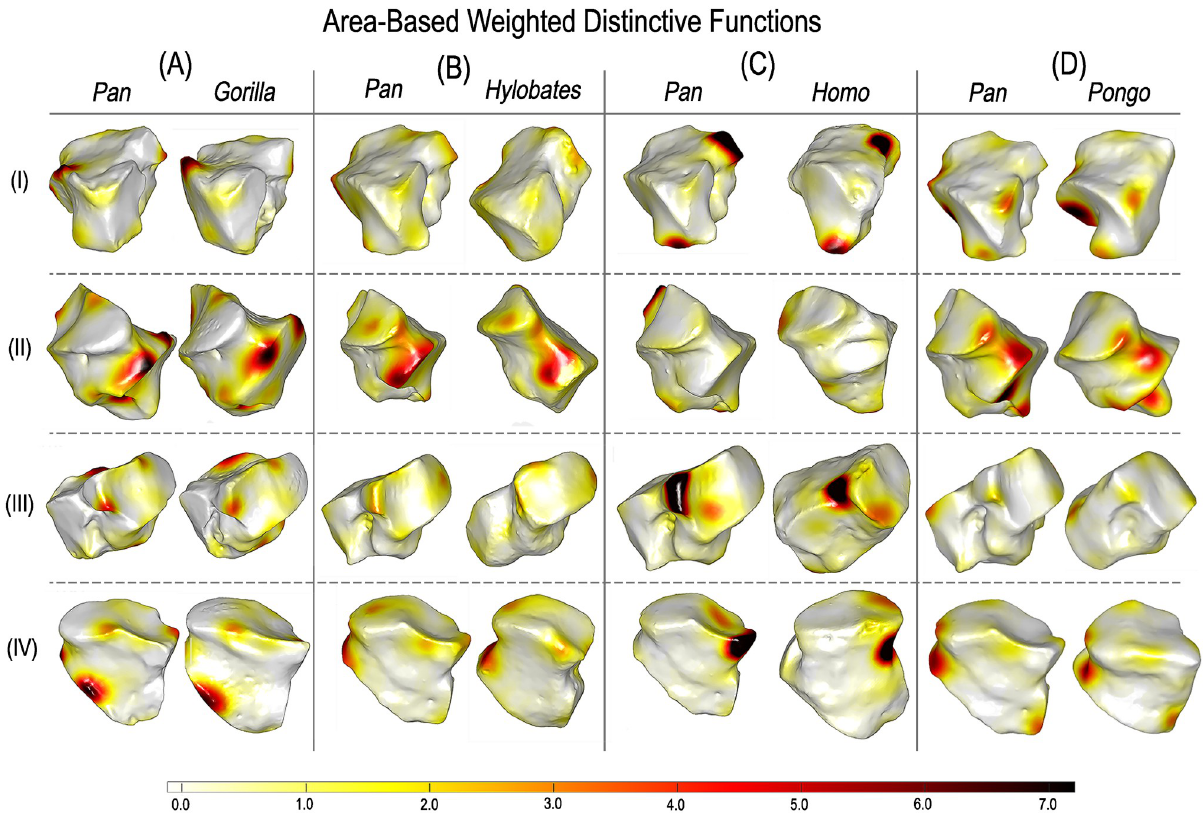
Fig 8. Weighted distinctive functions highlighting where regions are most variable in area-based distortion between hominoid groups. Dark red indicates the most variability, white the least. Rows: I Proximo-medial view; II Lateral; III Medio-distal; IV